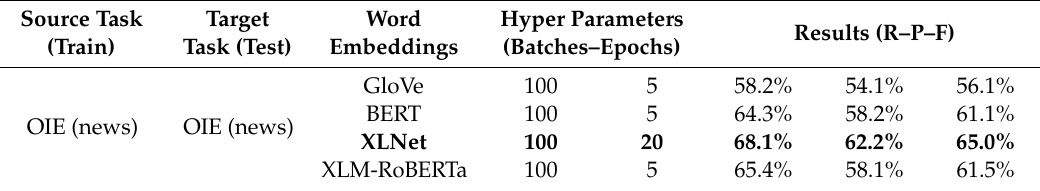
Table 5. Results of the ROIE model using different word embeddings. Both training and testing were done on the OIE WikiNews dataset. Recall (R), precision (P), and F-measure (F) were used as evaluation